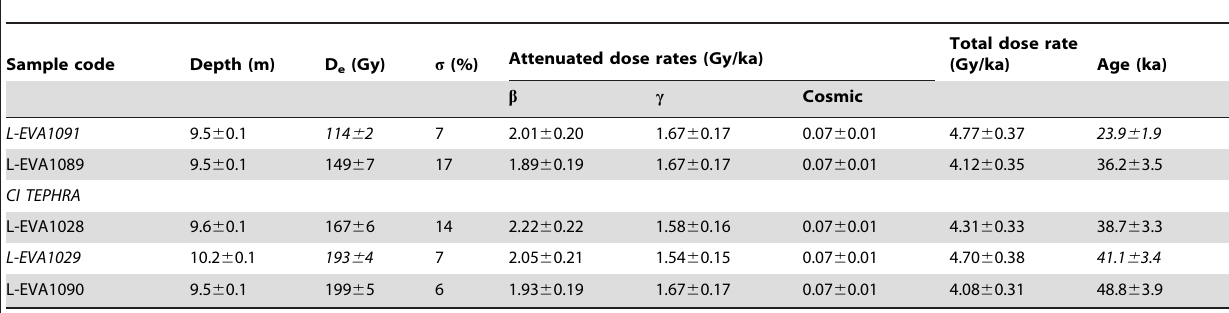
Table 2. Luminescence dating data and age estimates for the CI tephra at the Urluia site.